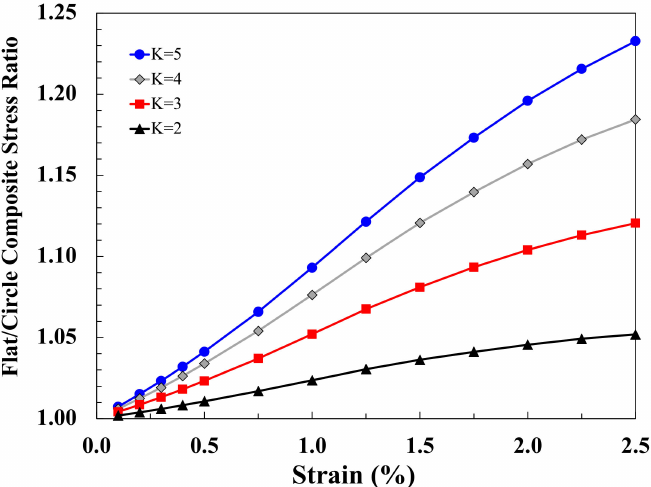
Figure 10. Prediction of flat/circle ratio of stress in injection moulded 40% GF-PP composites for different flatness